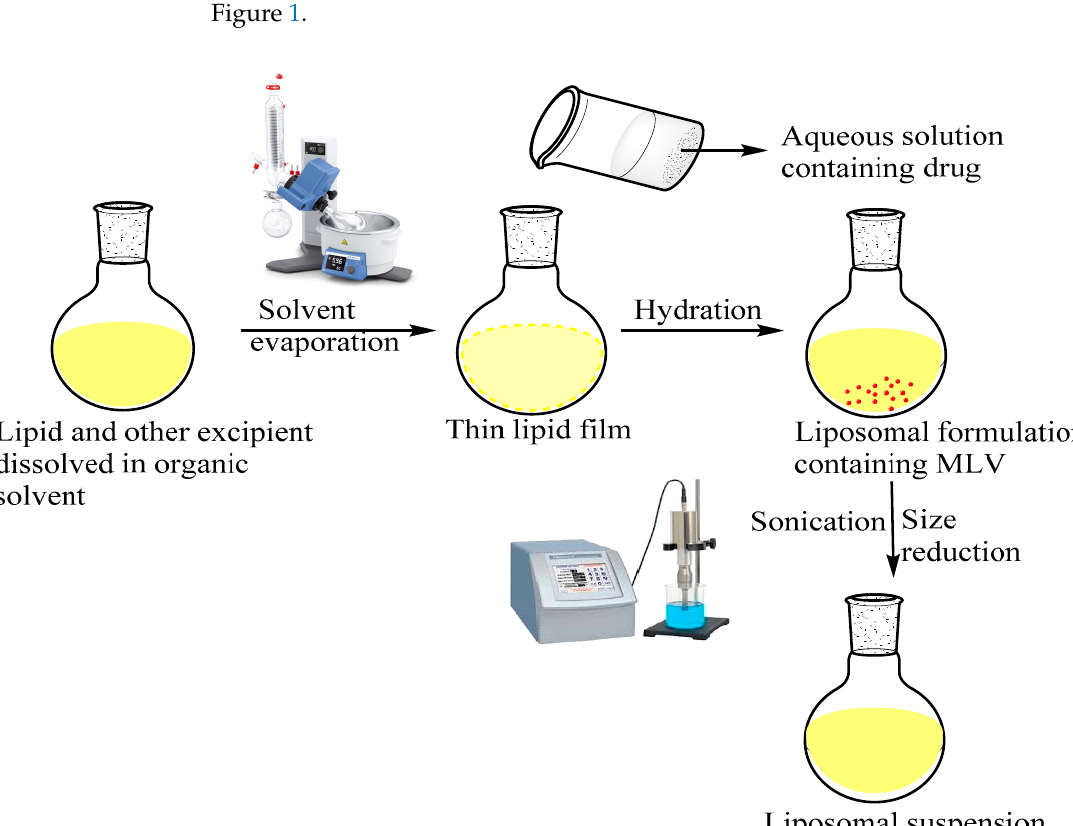
Figure 1. Graphical representation for the preparation of Azacitidine (AZA)-loaded liposomes.